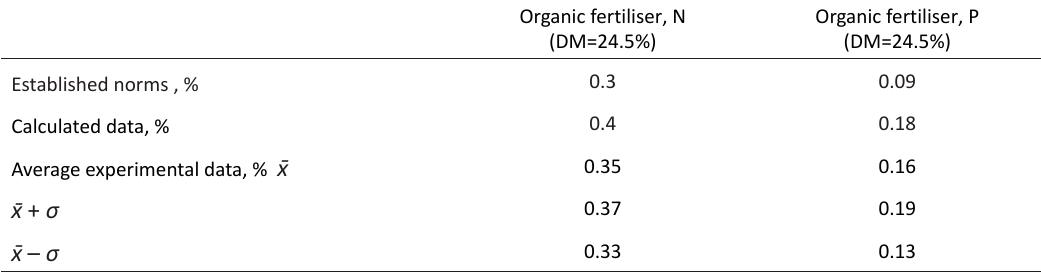
Table 6. Total nitrogen and phosphorus content in the organic fertiliser produced by composting solid cattle manure (manure at ex-storage level) (fresh